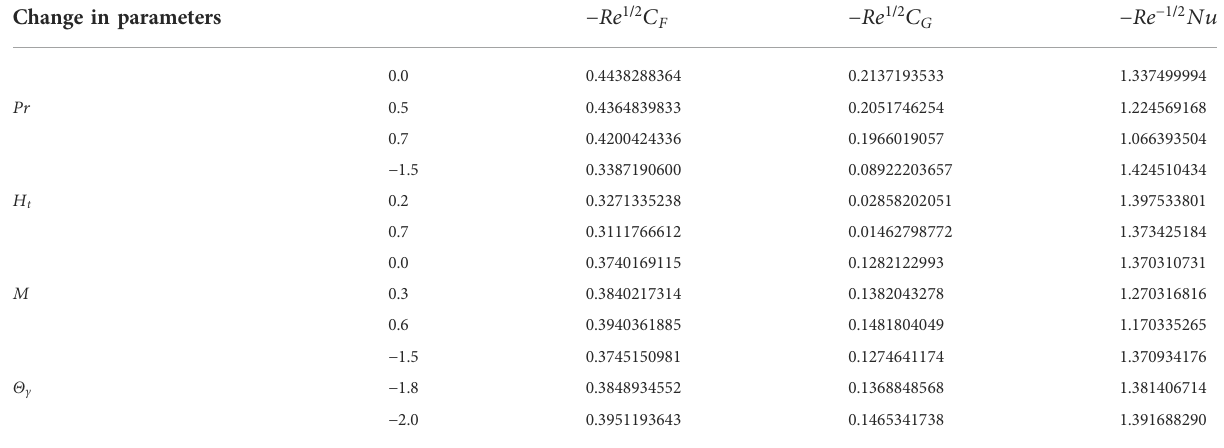
TABLE 3 Numerical impacts of shear stresses and temperature gradient versus Pr , M , H t , and Θ γ . Change in